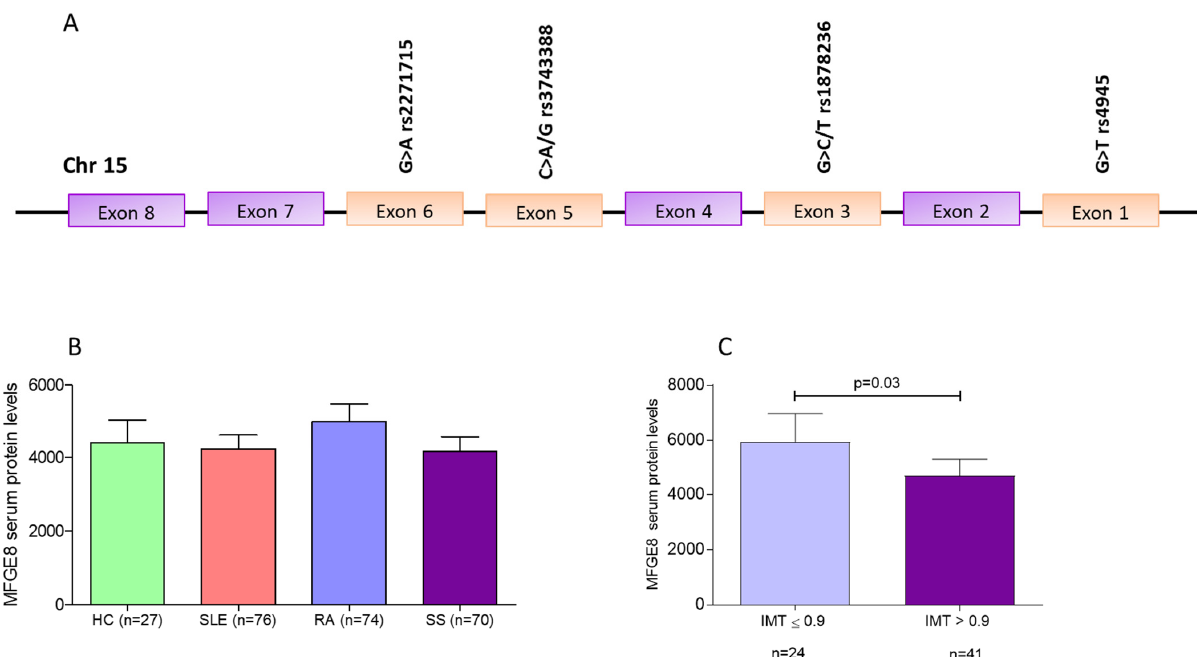
Figure 1. Chromosomal location of the MFGE8 variants and MFGE8 protein serum levels between SLE, RA, SS patients and HC. ( A ). Chromosomal location of the MFGE8 variants ( B ). No differences in MFGE8 serum levels were found between SLE, RA, SS patients and HC. ( C ). Significantly higher MFGE8 protein levels in the serum of SS patients with IMT ≤ 0.9 mm compared to SS patients with